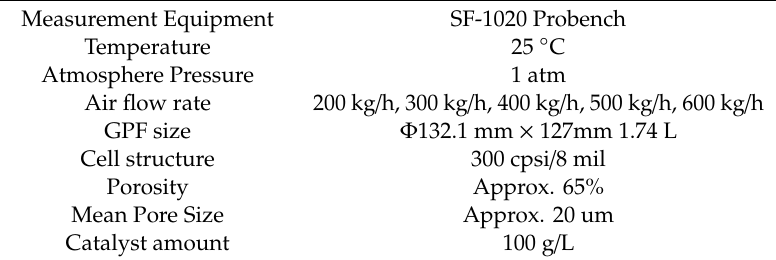
Figure 1. Measurement equipment SF-1020 Probench. Table 2. Measurement conditions of the pressure drop on the GPF.